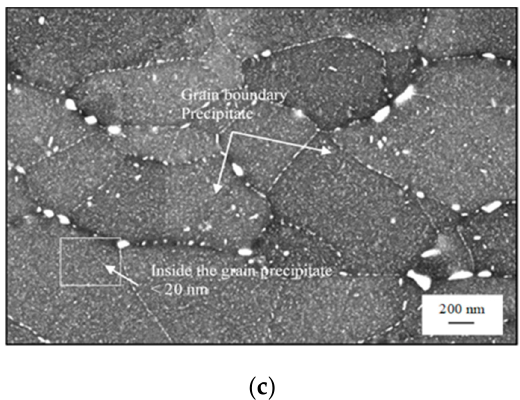
Figure 3. Warm upsetting temperature effect on the precipitation state of the AA7050 alloy. ( a ) Specimen A (upsetting at T = 293 K); ( b ) specimen B (upsetting at T = 423 K) and ( c ) specimen C (upsetting at T = 473 K; SEM-FEG images at 50 KX magnification).